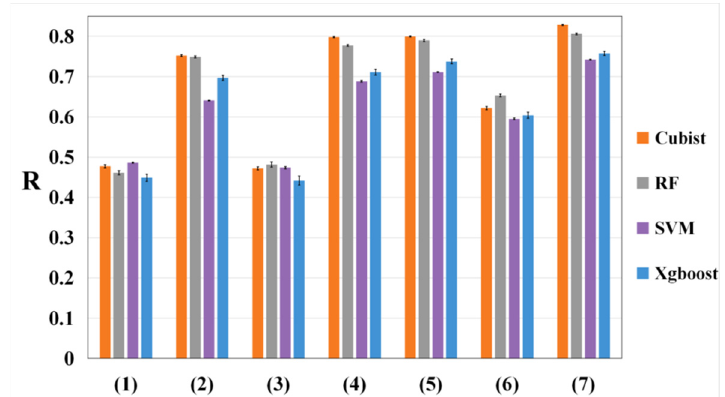
Figure 4. The model performances (estimated R values) of the different methods include combina- tions: (1) satellite data (EVI, NDVI, and SAVI), (2) climate data, (3) meteorological indices, (4) climate and satellite data (EVI, NDVI, and SAVI), (5) climate data and meteorological indices, (6) satellite data (EVI, NDVI, and SAVI) and meteorological indices; and (7) climate, satellite (EVI, NDVI, and SAVI) and meteorological indices, input for the whole growing season. The error bars are one standard deviation of predicted R from 10 ensembles by dividing the training and testing datasets randomly.